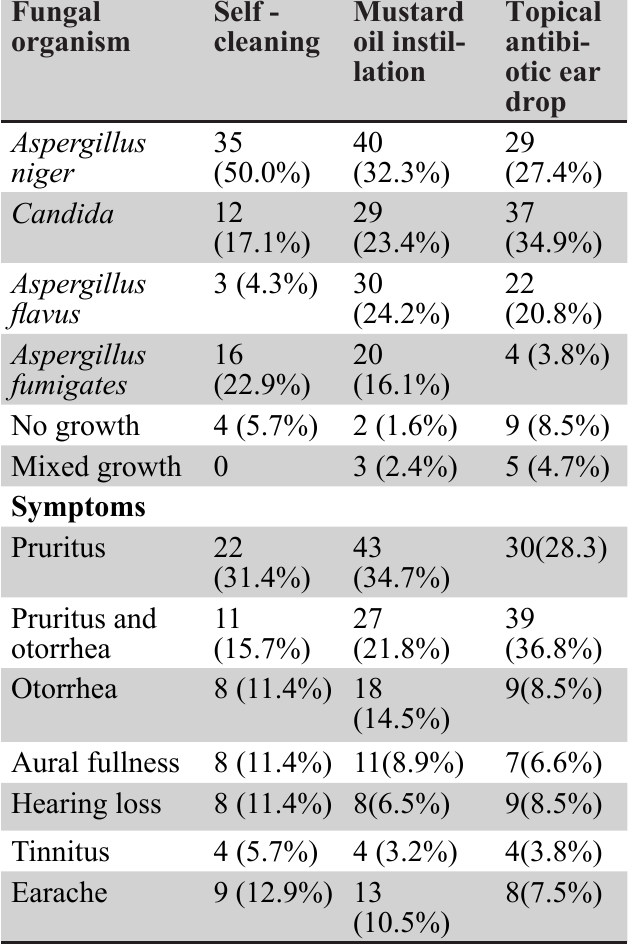
Table 2. Distribution of Pre-disposing Factors with Fungal Organism and Clinical Characteristics (N = 300).